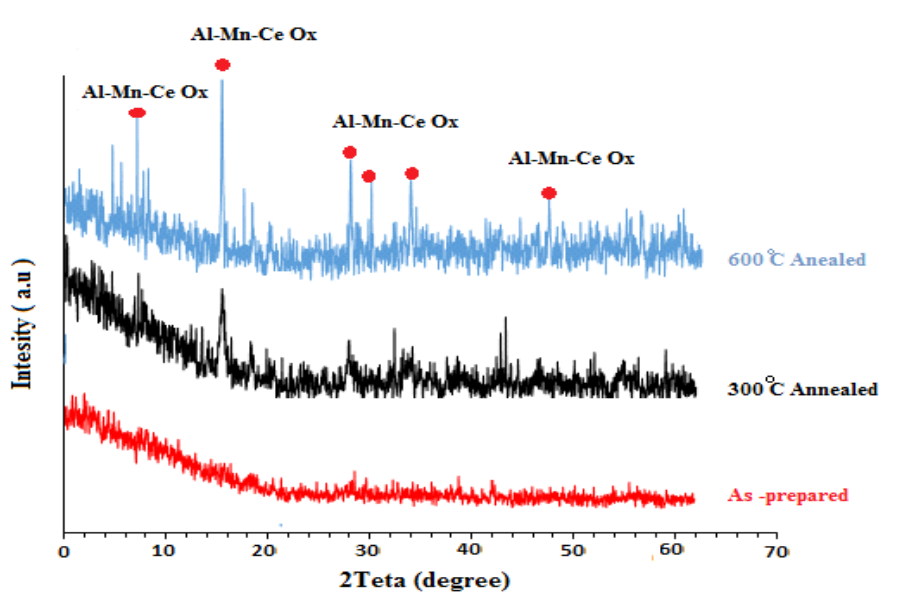
Fig. 3, XRD pattern of as-prepared and temperature annealed (300 and 600 ˚C)